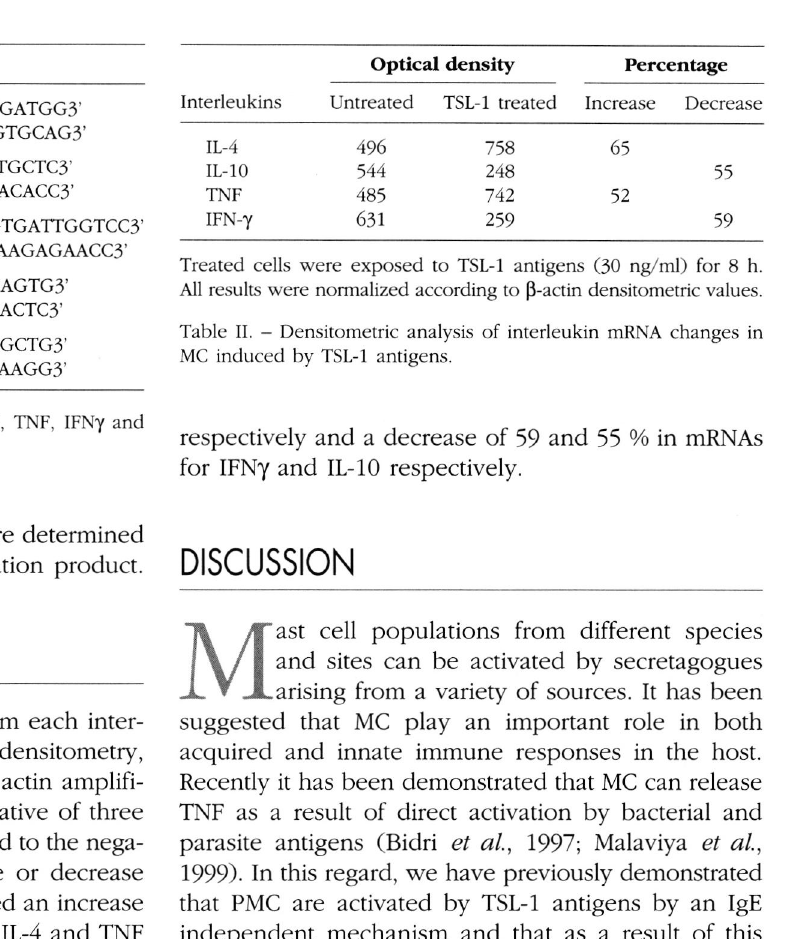
Table I. - PCR primers specific for rat IL-4, IL-10, TNF, IFNy and ß actin.